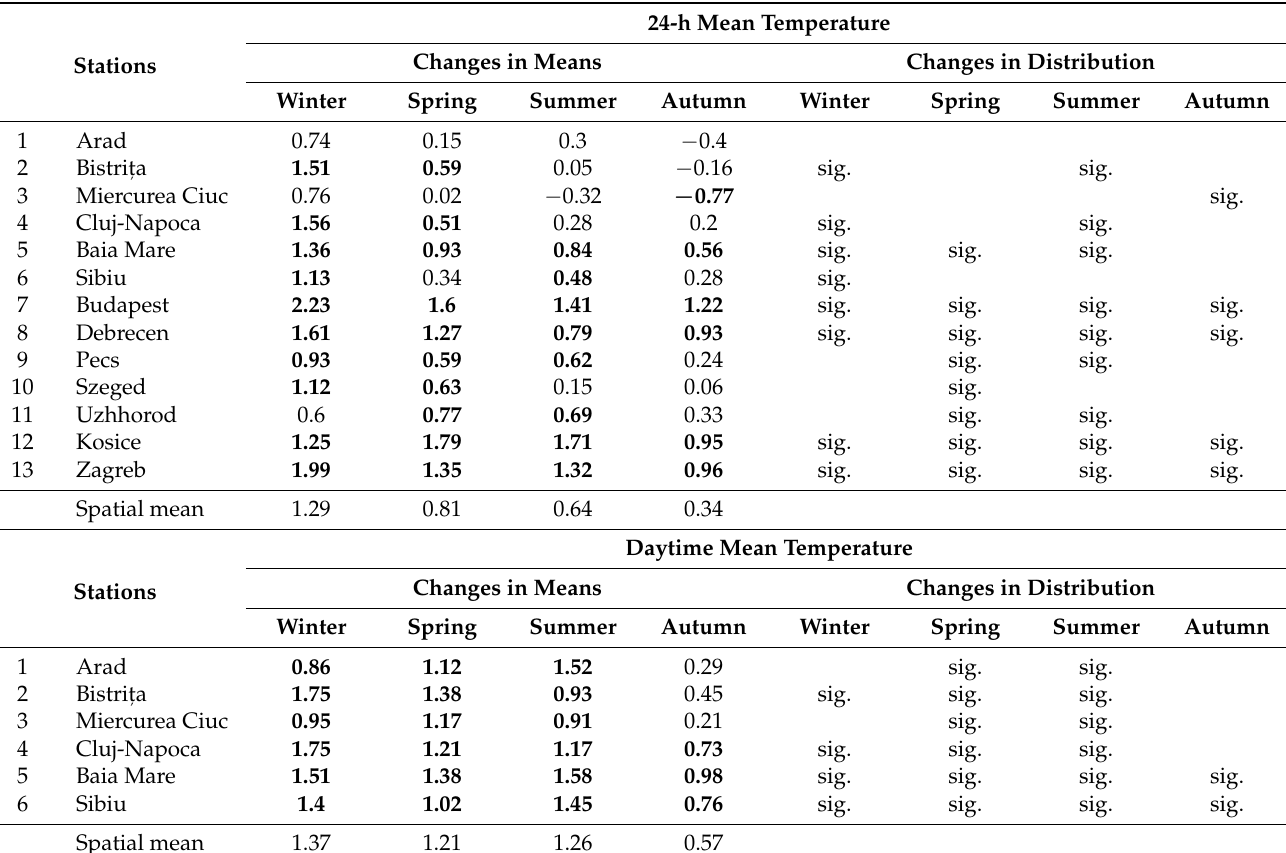
both in winter. Table S3 of Supplementary Material presents the values ( ◦ C) of multiannual 24 h temperature means for the two periods. Table 1. Changes in daily (24 h) and daytime (the average of observations at 7 a.m., 2 p.m., and 9 p.m.) mean temperature in ◦ C (upper) and probability distribution of mean temperature (bottom) between historical (1871–1918) and current (1971–2020) periods in Carpathian Region. Bold values and sig. indicate significant changes at the 0.05 significance